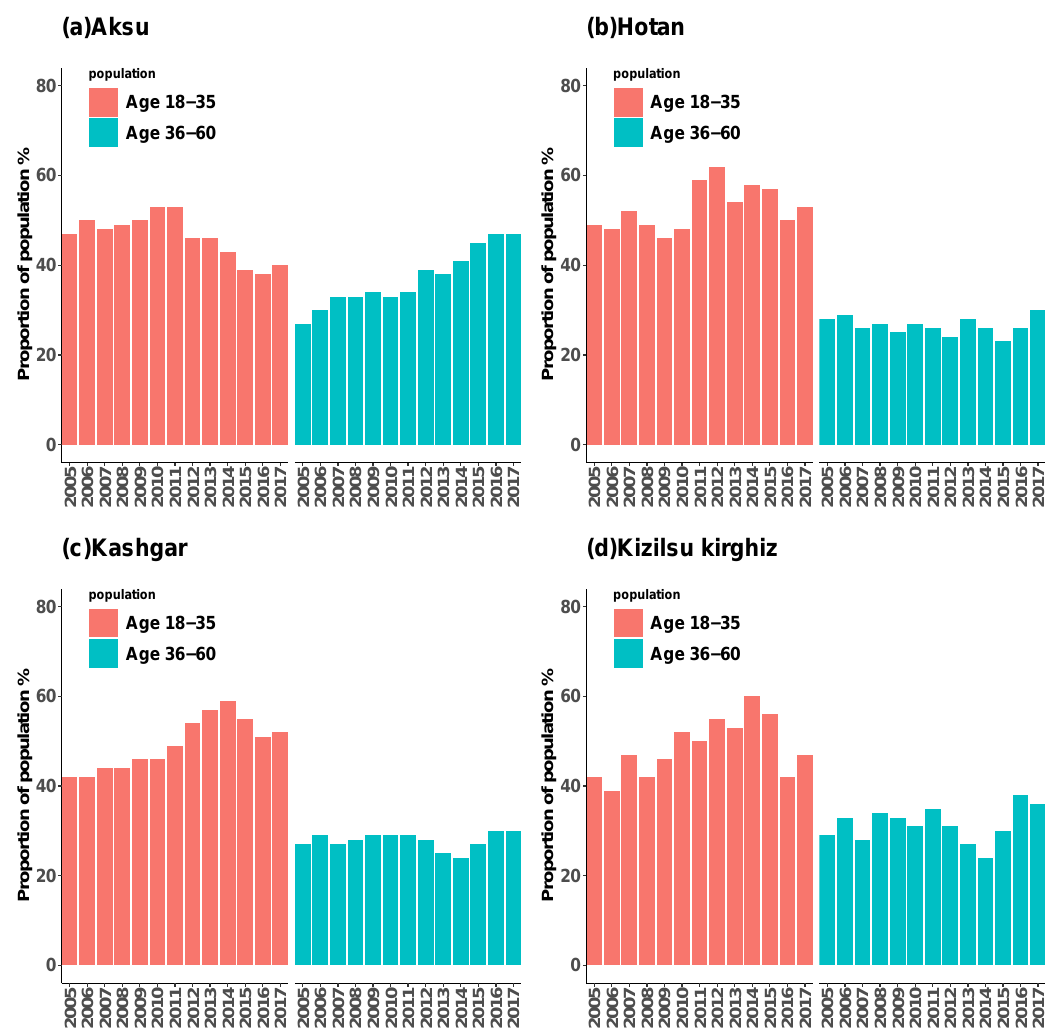
Figure 8. The incidence of HB among young adults aged 18–35 and middle-aged people aged 36–60 years in four regions of Xinjiang, China, from 2005 to 2017 (%). In each group, red meant young people and blue meant middle-aged